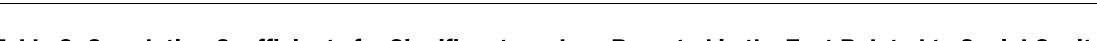
Table 2. Correlation Coefficients for Significant p -values Reported in the Text Related to Social Capital For all tests, n =306 (153 farmers, 153